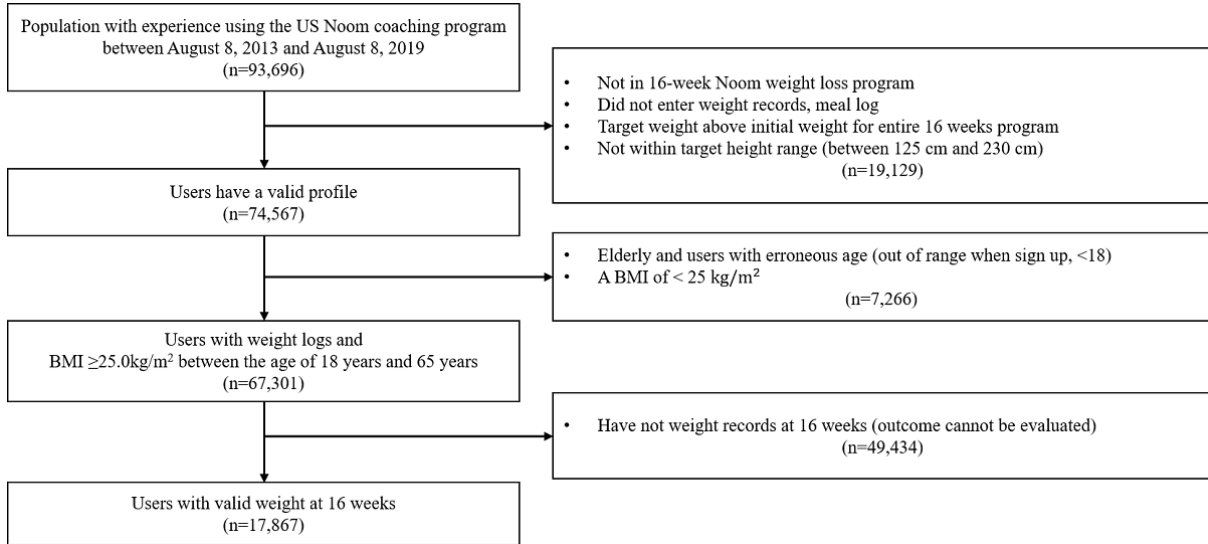
Figure 1. Selection flow for eligible users.